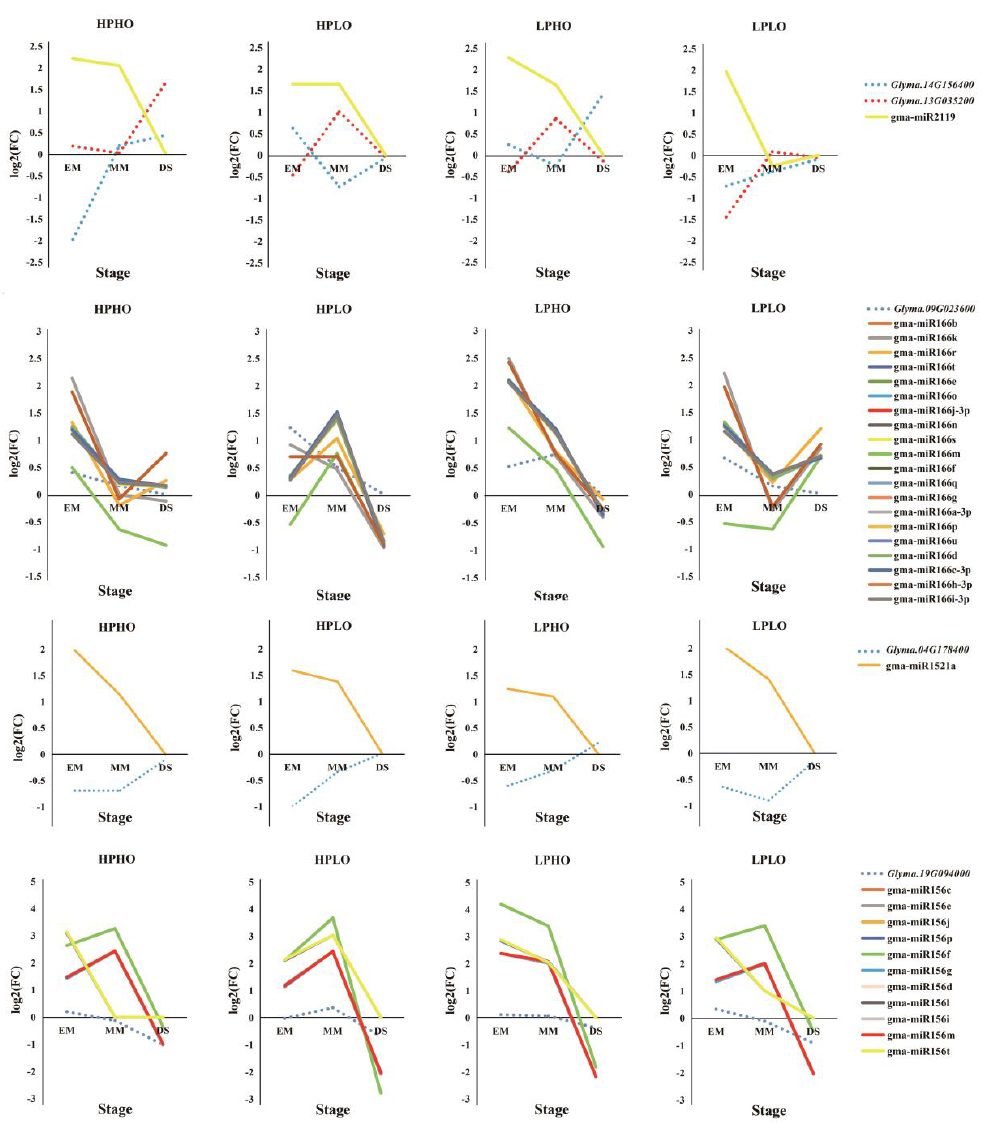
Figure 6. Expression relationship between miRNA and its target gene. The dotted line represented the trend of the gene expression in each stage. The solid line represented the trend of miRNA expression in various stages. The X -axis represents the developmental stage of the seed, and the Y -axis represents the relative expression level.